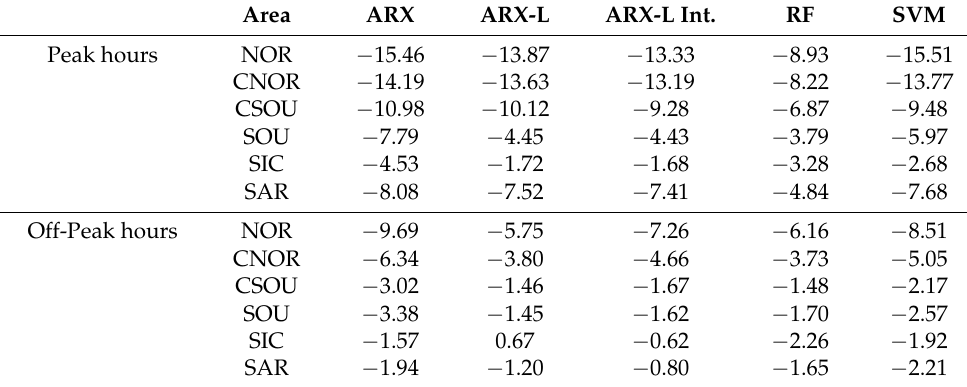
Table 7. Percentage variation of the mean values of RMSE over peak and off-peak hours with respect to the case in which no exogenous variables were included in the regressors